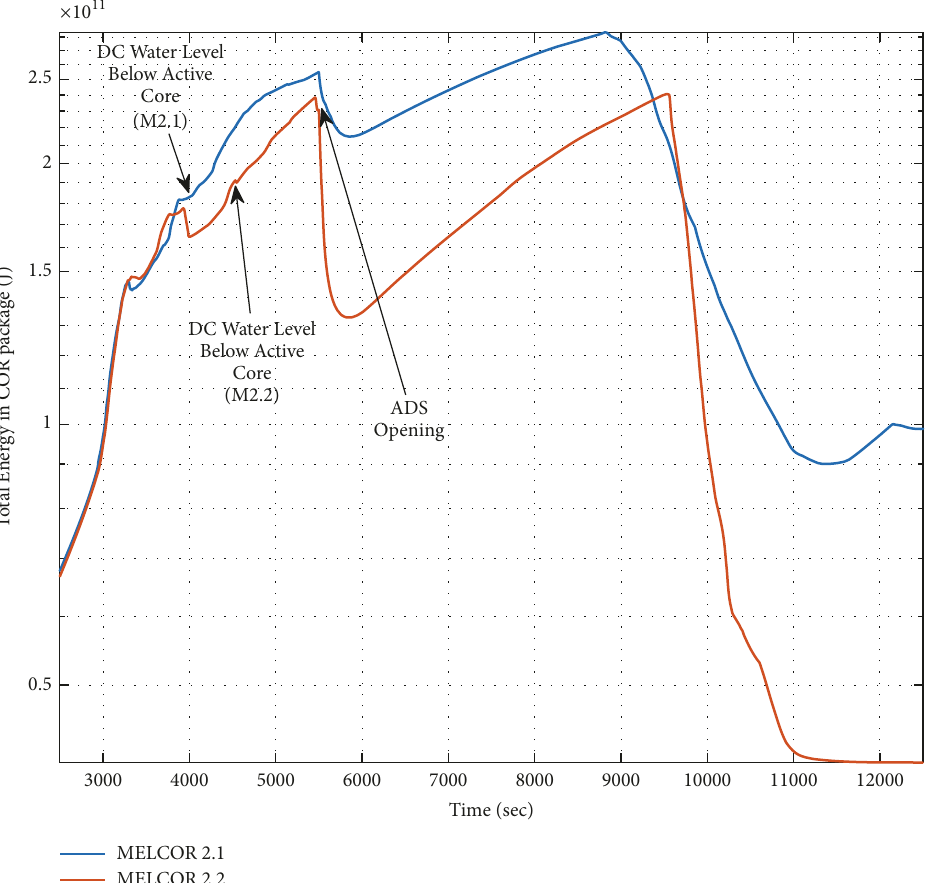
Figure 17: MELCOR 2.1 and 2.2 predictions of total energy in COR package (J).